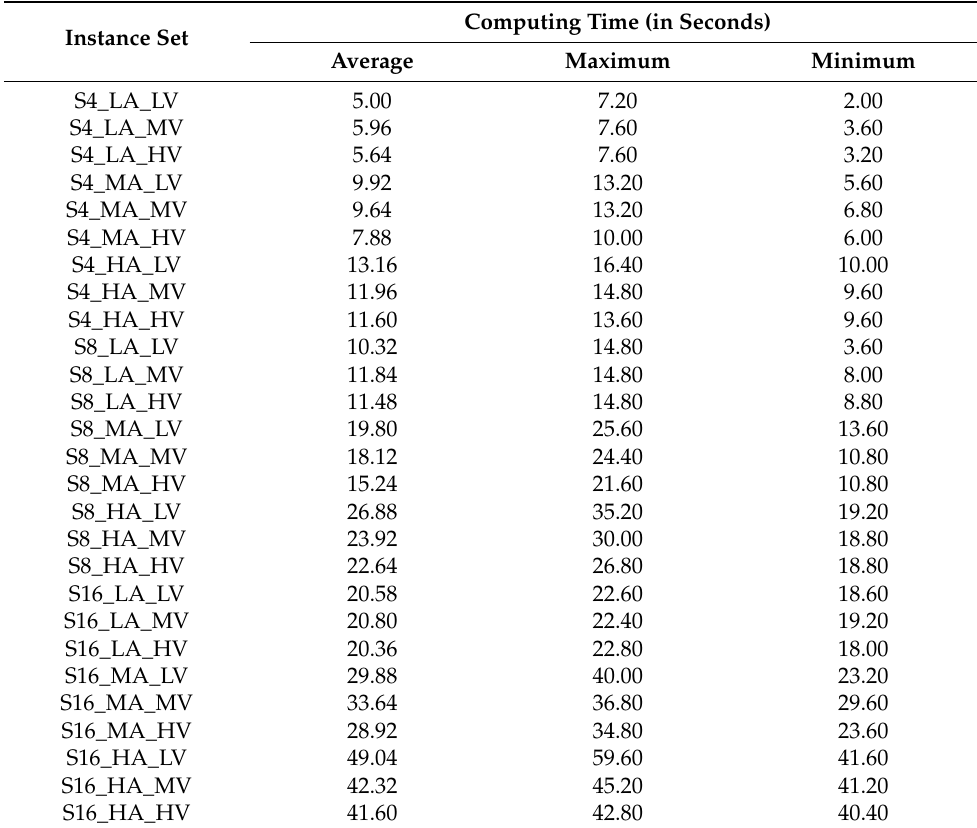
Table 6. Average, maximum, and minimum computing time (in seconds) required by the evolutionary algorithm for each instance